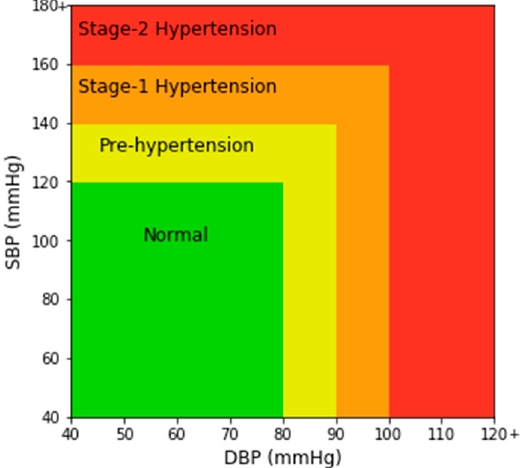
Figure 3. Chart of different blood pressure (BP) ranges.